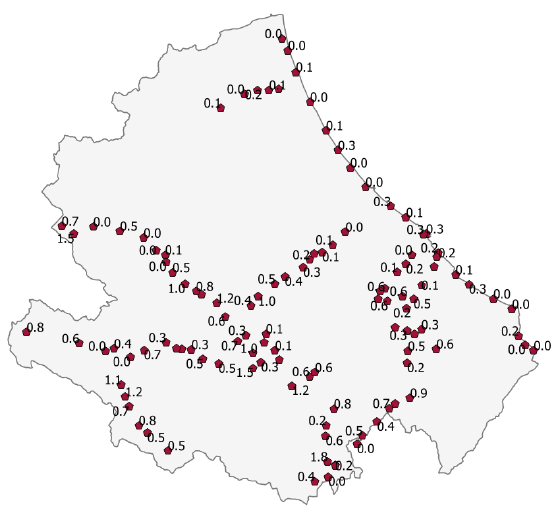
Figure 9. A pictorial representation of the ranking of the 114 railway stations of Abruzzo. Table 1. The ranking of the 114 railway stations of